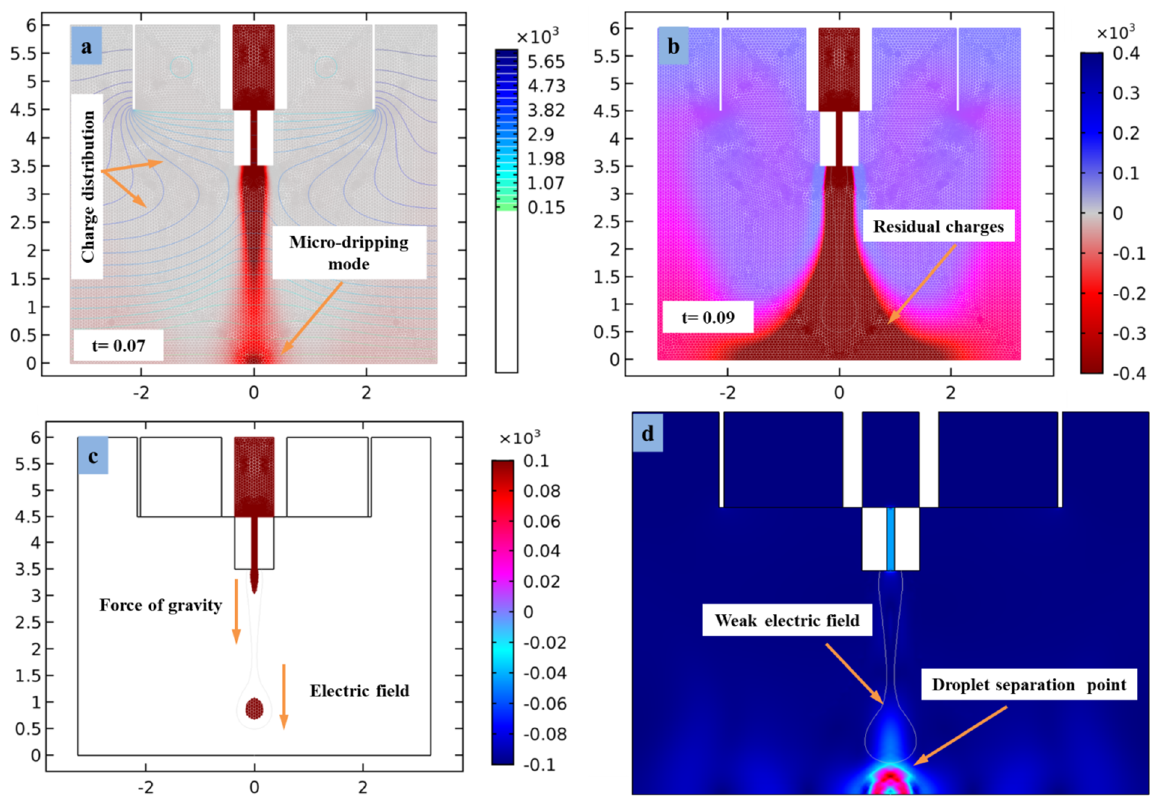
Figure 5. ( a , b ) Distribution of volume charge density around cone-jet morphology, ( c ) effect of electric field on droplet, ( d ) inflation in droplet size during weak electrical forces .